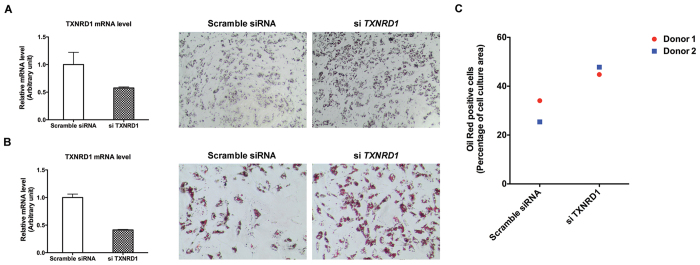
TXNRD1 knockdown promotes adipogenesis in human pre-adipocytes.(A) Left panel, pre-adipocytes isolated from donor 1 were cultured with additional of 50 nM selenite, transfected with scramble siRNA or with siRNA against TXNRD1, with mRNA levels of TXNRD1 in these cells measured using real time-PCR and plotted as normalized to LRP10 (n = 3, ±SEM). Right panel, the same treated cells were induced for adipocyte differentiation for 6 days. Thereafter, the PPARγ agonist was removed from the medium and the cells were incubated for additional 5 days before Oil Red-O staining; 4x magnification was used for imaging. (B) Pre-adipocytes isolated from donor 2 were plated without selenite supplementation, and subsequently treated and analyzed the same way as described in A; 10x magnification was used for imaging. (C) Oil Red-O staining in (A,B) plotted upon quantification using the Image J software.